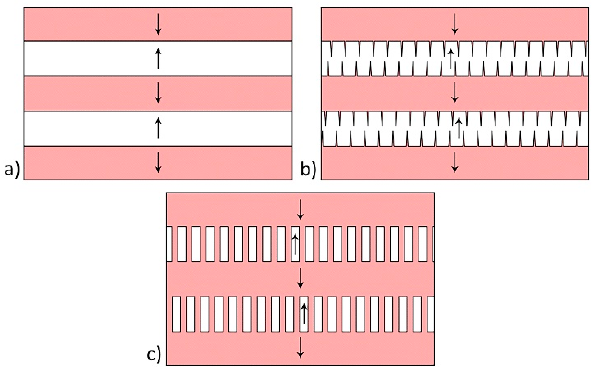
Figure 3. Schematic images of domain walls: ( a ) The formation of elementary steps, ( b ) macrostep with increased kink concentration, and ( c ) domain walls with uniform kink distribution. The arrows indicate the spontaneous polarization directions.